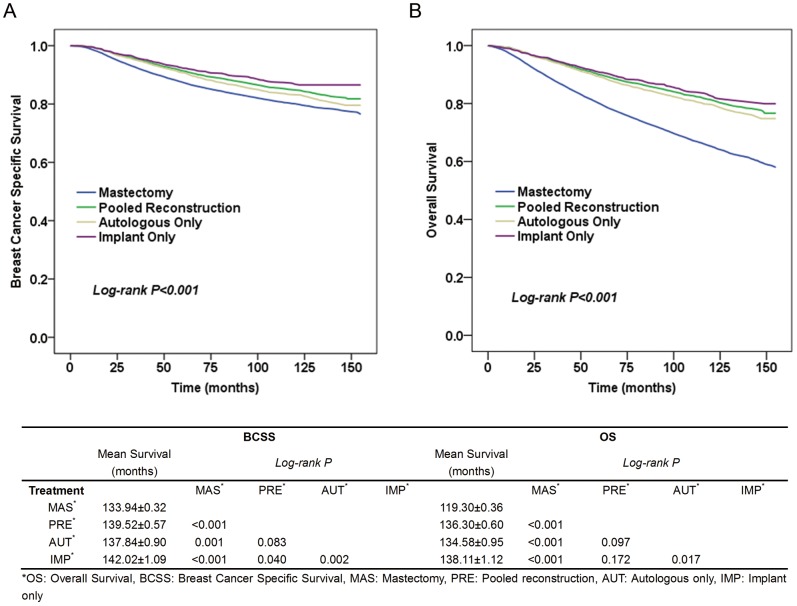
Kaplan–Meier estimates of breast cancer-specific survival and overall survival according to different treatments.
A: Breast cancer specific survival, B: Overall survival. The table below lists the results of pairwise comparisons of breast cancer-specific survival and overall survival between different treatment groups.